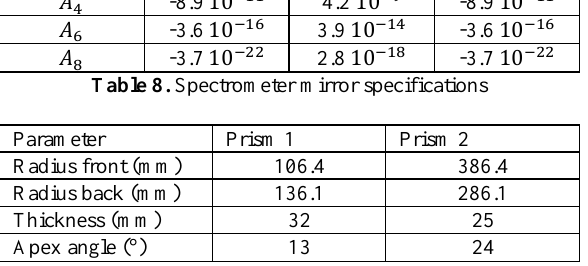
Table 7. Spectrometer prism specifications